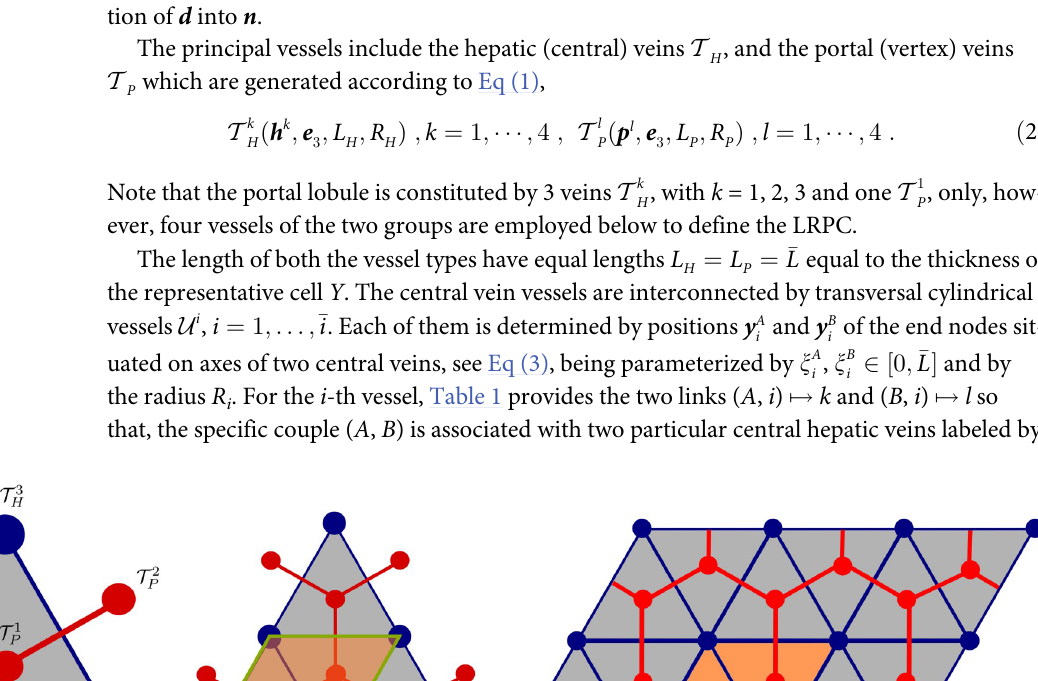
, d = h , p . Middle & Right: The LRPC is obtained by translations, see Eqs d